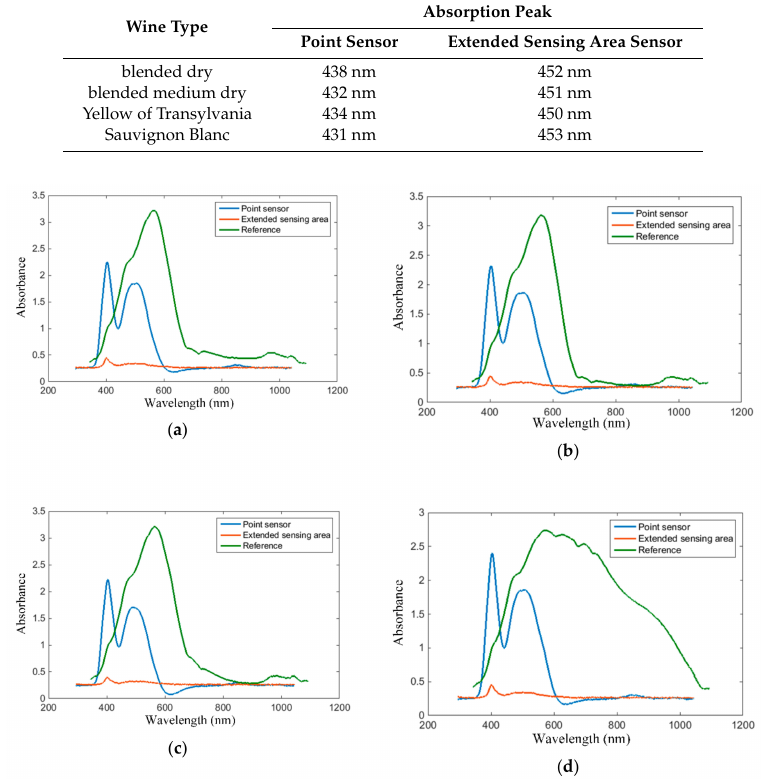
Table 2. White wine absorption peaks, acquired with the point and extended sensing area intra-oral sensors, respectively.